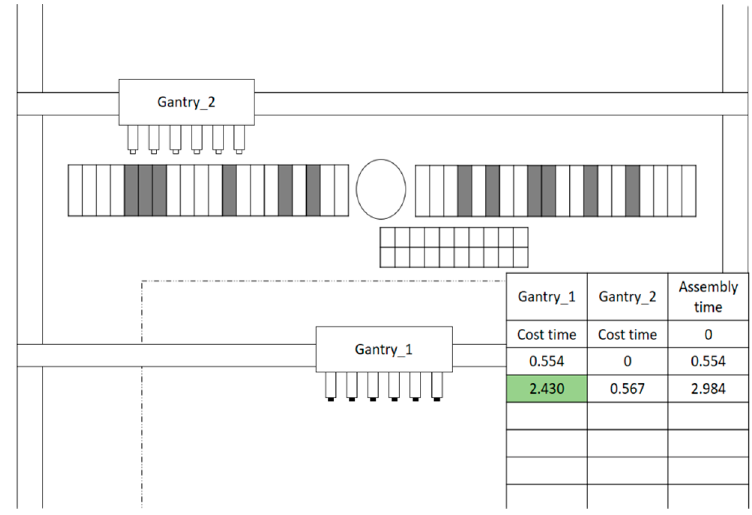
Figure 20. Gantry_1 is placing, and Gantry_2 is picking components.